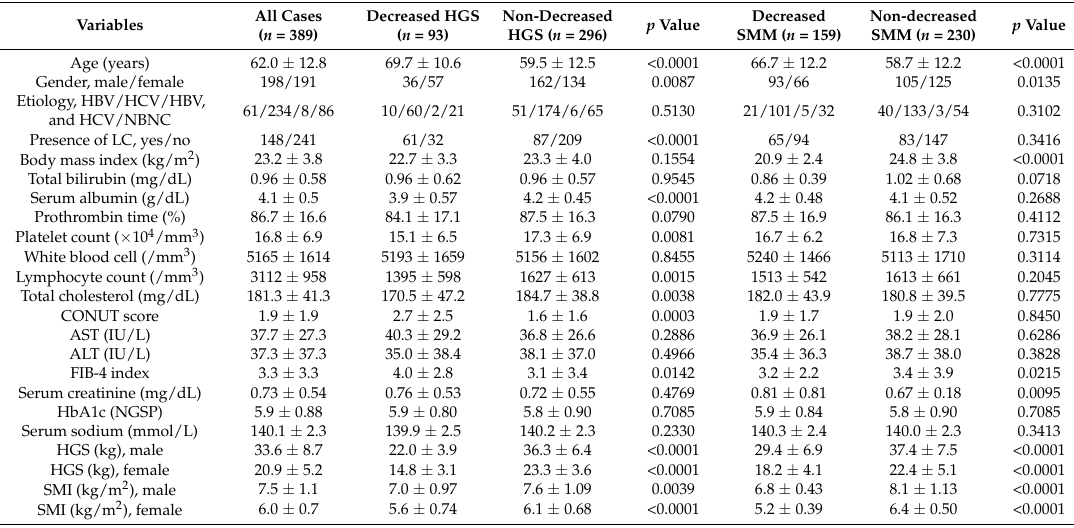
Table 1. Baseline characteristics.